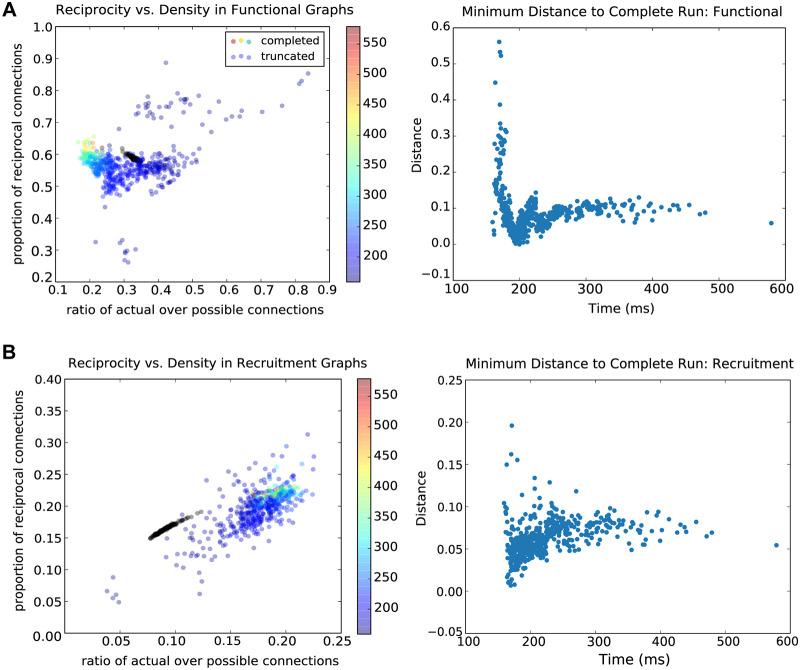
Standard network reciprocity.A: The left-hand panel shows the reciprocity (ratio of reciprocal connections to total connections) of functional graphs plotted as a function of their density (ratio of existing to possible connections). Data points for sustained runs are plotted in black and form a tight cluster, whereas those for truncated runs are varied. Truncated runs are colored by the ratio of inhibitory to excitatory spike rates. The right-hand panel shows the minimum distance (in reciprocity vs. density coordinate space for functional graphs) between each truncated run and a sustained run as a function of truncation time. Truncated runs which have greater than 200ms duration level off in their minimum distance. Thus, past a certain threshold, the difference between truncated and sustained runs’ density and reciprocity is not related to the run duration. B: The left-hand panel shows the reciprocity (ratio of reciprocal connections to total connections) of recruitment graphs plotted as a function of their density (ratio of existing to possible connections). Sustained runs are plotted in black and form a neat relationship between density and reciprocity and occur within a limited range of values. As in panel A, truncated runs are more diffuse. The color of each point indicates the ratio of inhibitory to excitatory spike rates. And also as in panel A, the right-hand panel shows the minimum distance between each truncated run and a sustained run (in reciprocity vs. density coordinate space) as a function of truncation time, this time for recruitment graphs. Truncated runs which have greater than 200ms duration level off in their minimum distance.